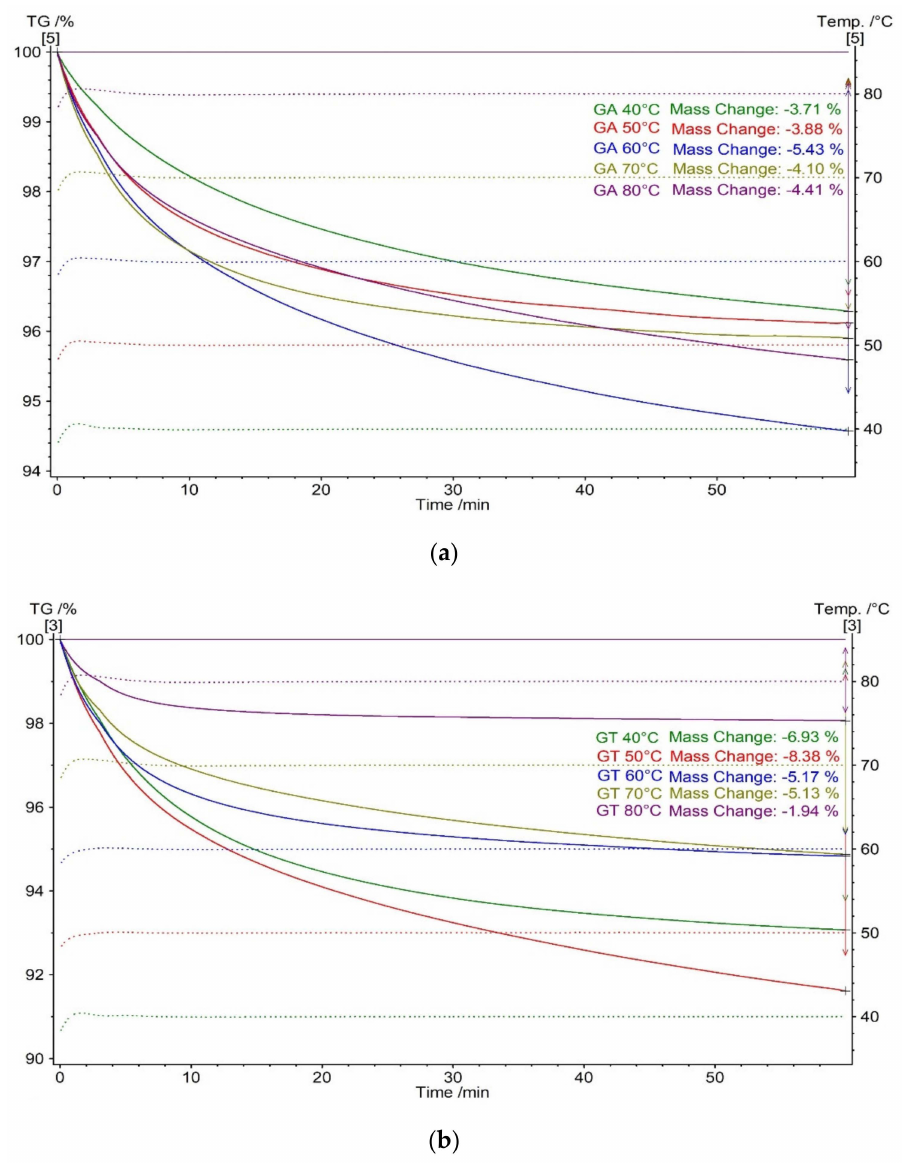
Figure 3. TG isothermal curves of ( a ) gum arabic and ( b ) gum tragacanth heated 60 min in the range of 40–80 ◦